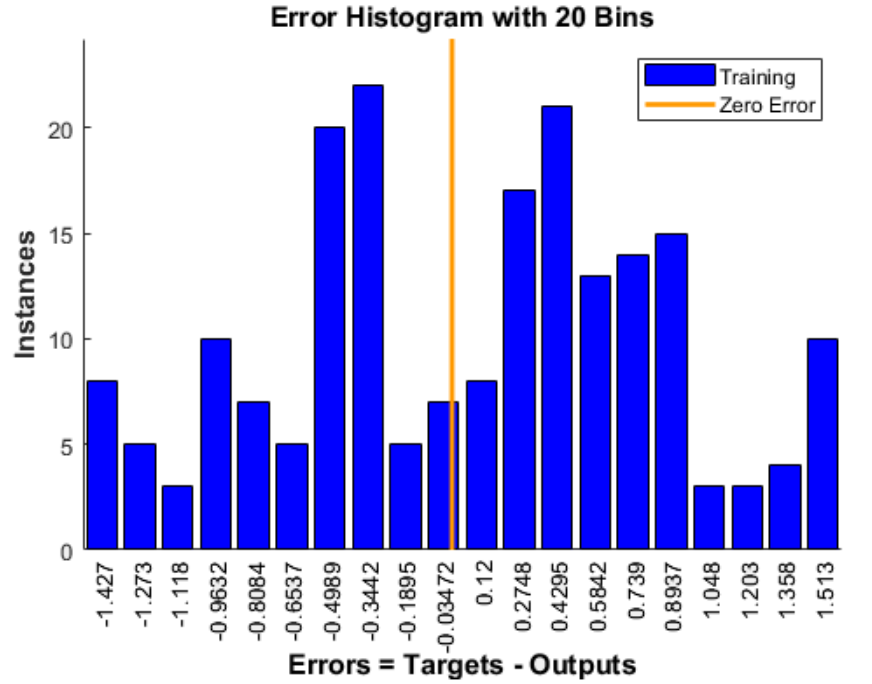
Figure 43. Neural network controller training state.